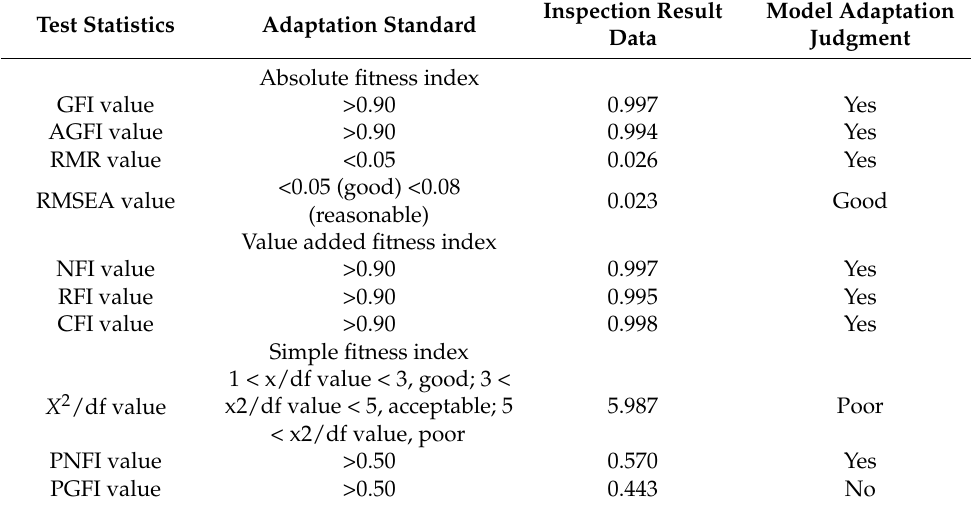
Table 12. Overall model fitness test results of overall relationship